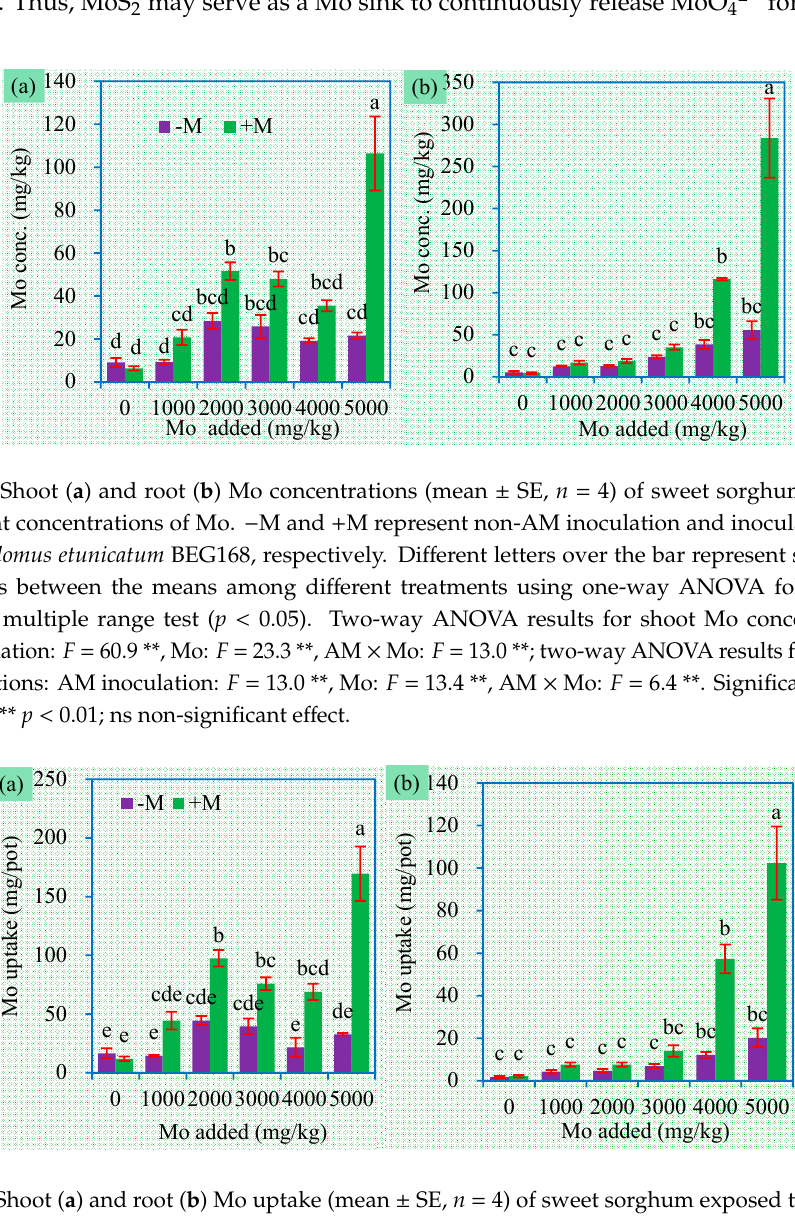
Figure 4. Shoot ( a ) and root ( b ) Mo uptake (mean ± SE, n = 4) of sweet sorghum exposed to di ff erent concentrations of Mo. − M and + M represent non-AM inoculation and inoculation with Claroideoglomus etunicatum BEG168, respectively. Di ff erent letters over the bar represent significant di ff erences between the means among di ff erent treatments using one-way ANOVA followed by Duncan’s multiple range test ( p < 0.05). Two-way ANOVA results for shoot Mo uptake: AM inoculation: F = 103.0 **, Mo: F = 26.5 **, AM × Mo: F = 15.4 **; two-way ANOVA results for root Mo uptake: AM inoculation: F = 43.3 **, Mo: F = 31.0 **, AM × Mo: F = 15.7 **. Significance levels: * p < 0.05; ** p < 0.01; ns non-significant e ff